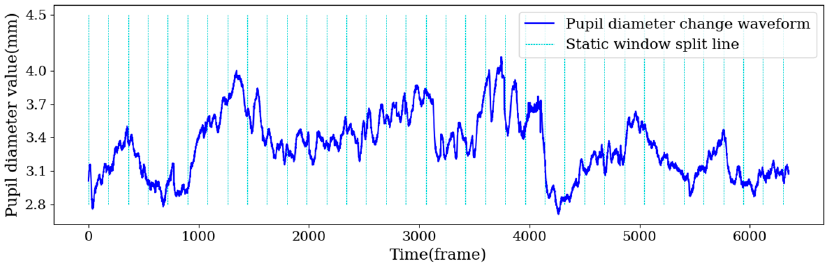
Figure 2. Schematic diagram of pupil diameter partitioning samples according to 3 s static